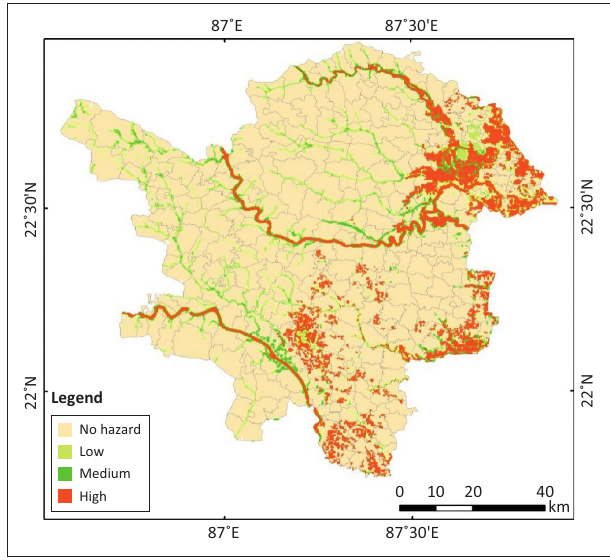
FIGURE 8: Flood hazard map obtained from flood-affected frequency and flood water depth together.